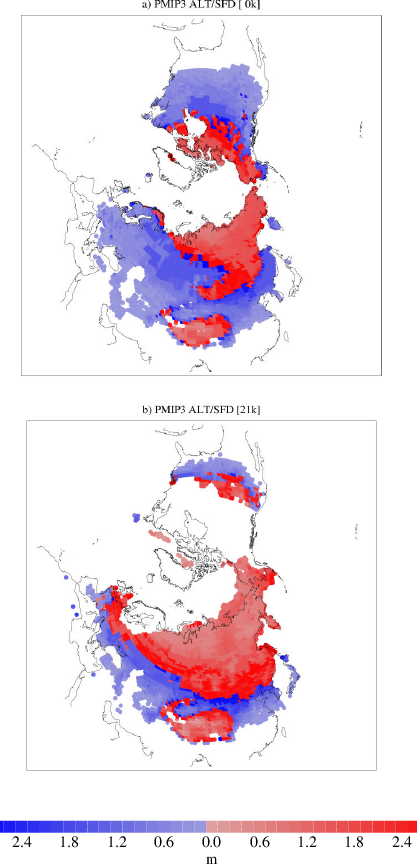
Fig. 4. (a) Multi-model median of maximum active layer depth (in red; for permafrost zones) and seasonal frost depth (in blue; for sea- sonally frozen ground zones) for the pre-industrial period. (b) same as (a) except for the LGM